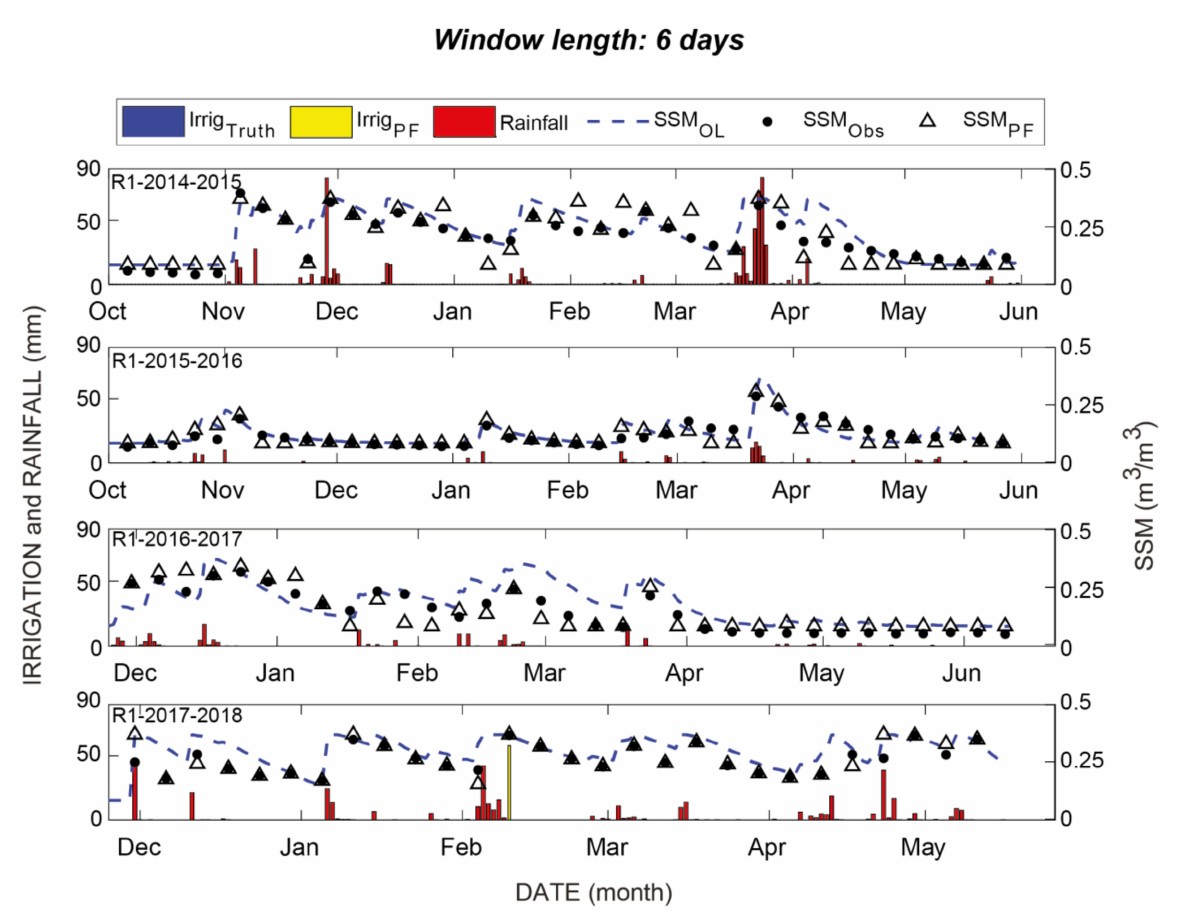
Figure A2. Time series of the estimated irrigation amounts and timing (Irrig PF ), the actual irrigation (Irrig Truth ) and the measured rainfall. Time series of the assimilated (SSM PF ), measured (SSM obs ) and the open loop (SSM OL ) SSM over the rainfed field (R1) for the four seasons for a window length of 6 days are also